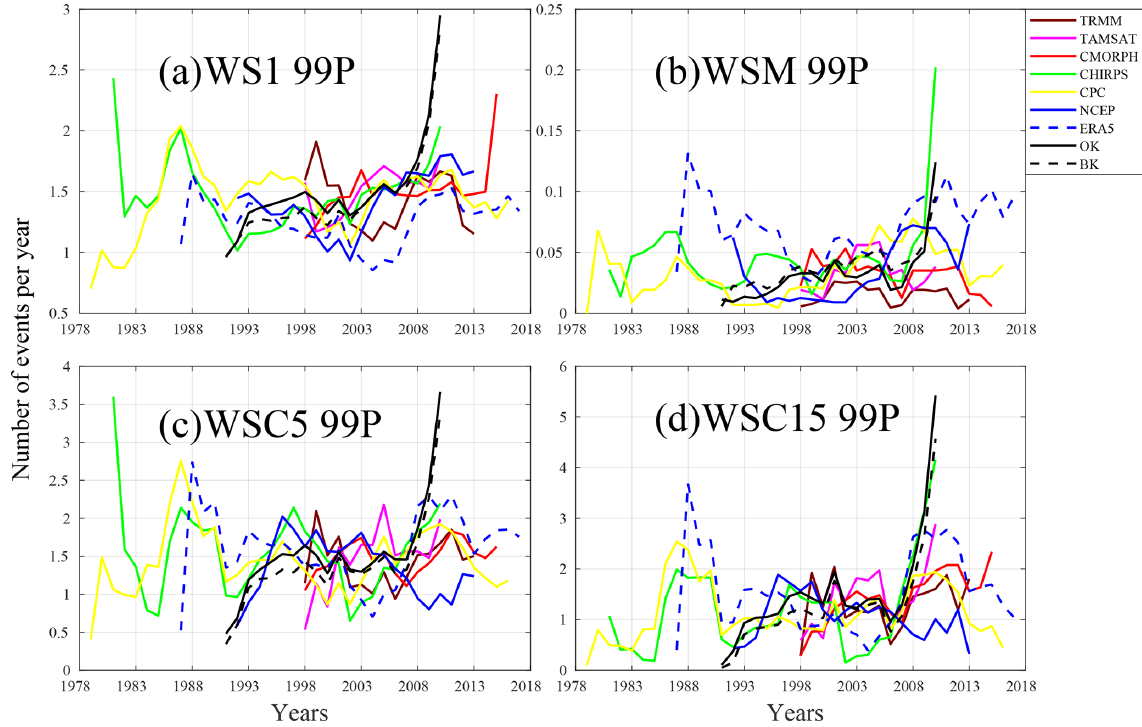
Figure 14. Inter-annual variability in average numbers on all grid points of WS1, WSM, WSC5, and WSC15 (99th percentile) computed over the period of availability for each dataset: TRMM (1998–2013), TAMSAT (1998–2010), CMORPH (1998–2015), CHIRPS (1981–2010), CPC (1979–2016), NCEP (1992–2013), ERA5 (1987–2017), BK (1991–2010), and OK (1991–2010). Details on the datasets and wet spells are provided in Tables 1 and 3,